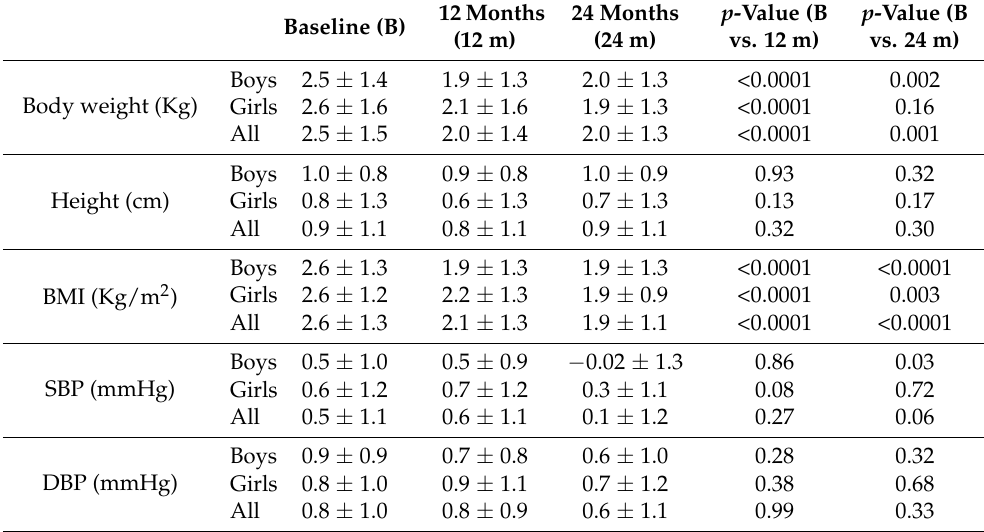
Table 2. SD (Z)-scores at baseline and after 12 and 24 months (m) of intervention in the total study population and by gender.